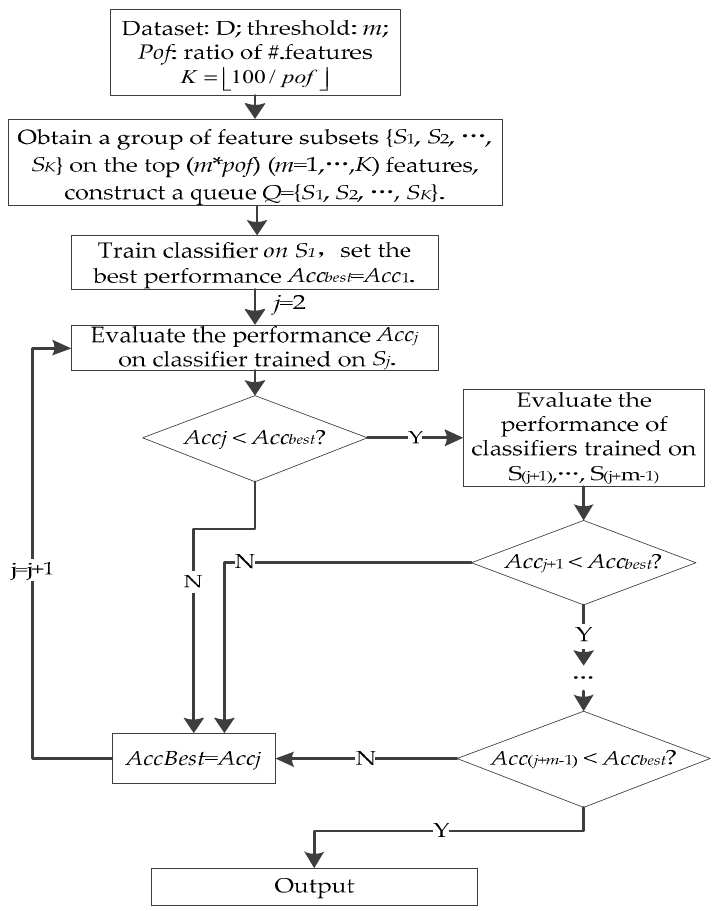
Figure 8. Flowchart of Forward Best-First Search (FBFS) strategy on modified chi-square test-based feature selection (MCFS) subsets.